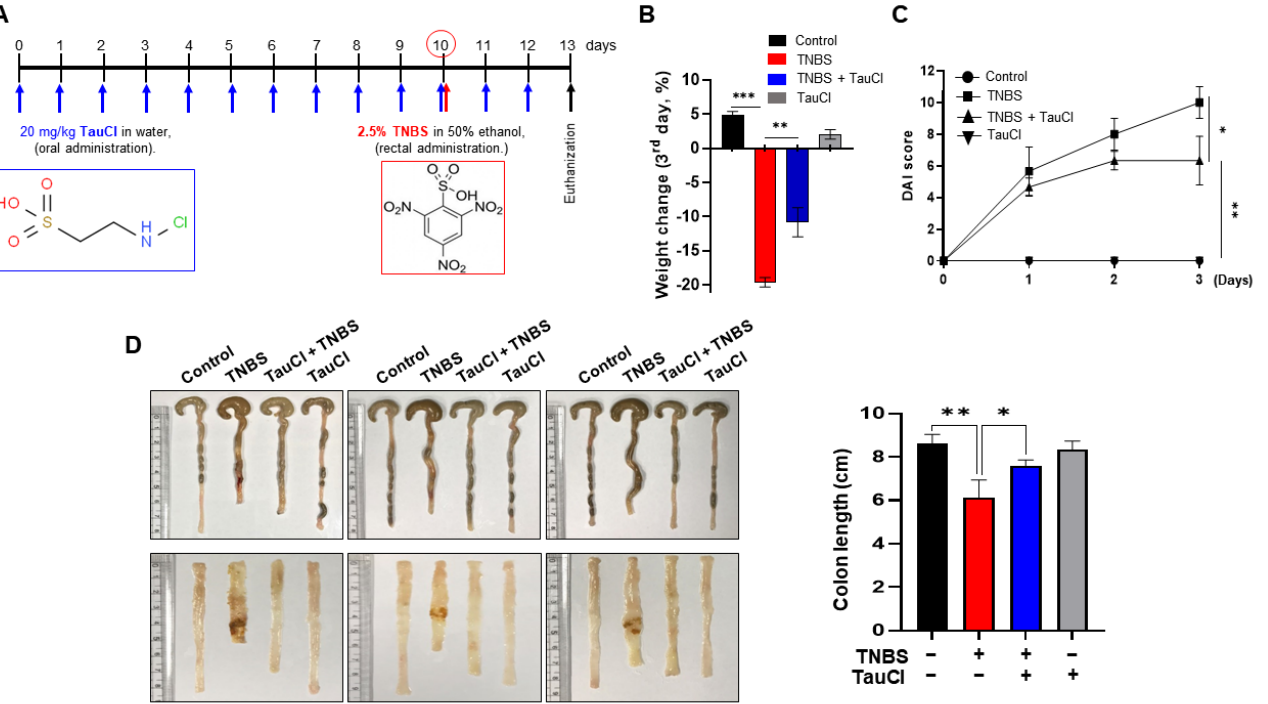
Figure 1. Effects of TauCl on inflammatory damage in the colon of TNBS-treated mice. ( A ) TauCl (20 mg/kg) was given on daily basis by gavage for 10 days before and for 3 days after intrarectal administration of 2.5% TNBS in EtOH. The comparison of body weight change ( B ), DAI ( C ), and colon length ( D ). Data are expressed as means ± SD ( n = 3 for each group). * , ** , *** Significantly different between groups compared (* p < 0.05; ** p < 0.01; *** p < 0.001).